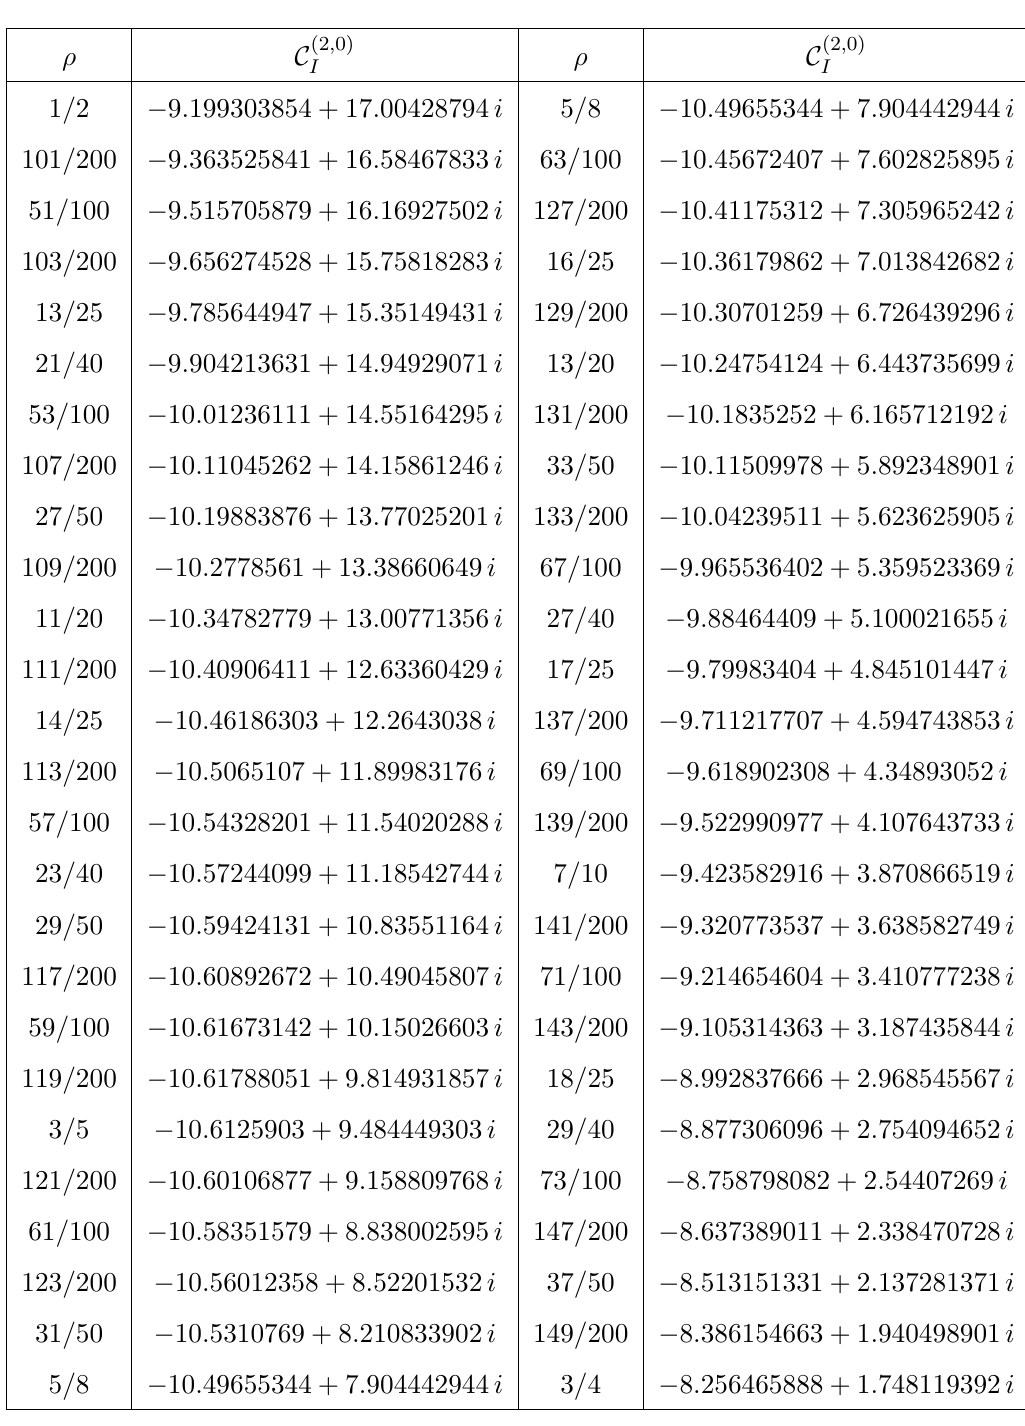
Table 2 . Numerical values of the three-loop coe(cid:14)cient of the (cid:12)nite remainder C (2)